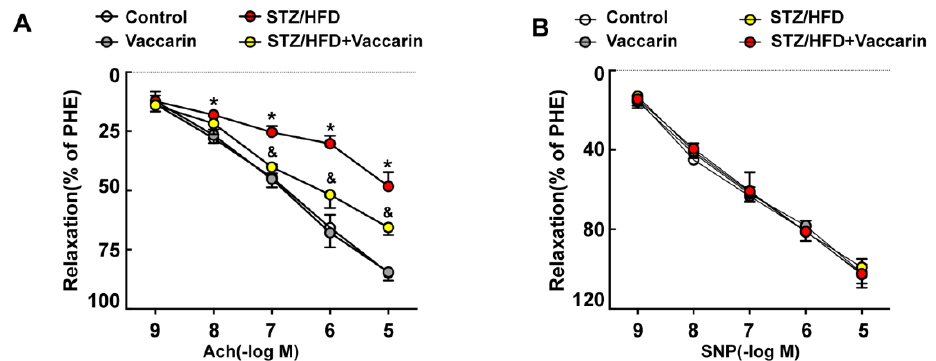
Figure 1. In vivo verification of vaccarin (VAC) e ff ects on vascular endothelial dysfunction in type 2 diabetes mellitus (T2DM) mice. ( A ) Endothelium-dependent vasorelaxation induced by di ff erent concentrations of acetyl choline (Ach, 10 − 9 M, 10 − 8 M, 10 − 7 M, 10 − 6 M, 10 − 5 M); ( B ) Endothelium-independent vasorelaxation induced by di ff erent concentrations of sodium nitroprusside (SNP, 10 − 9 M, 10 − 8 M, 10 − 7 M, 10 − 6 M, 10 − 5 M). Values are mean ± SD, * p < 0.05 vs control, & p < 0.05 vs STZ / HFD, n = 5 for each group.